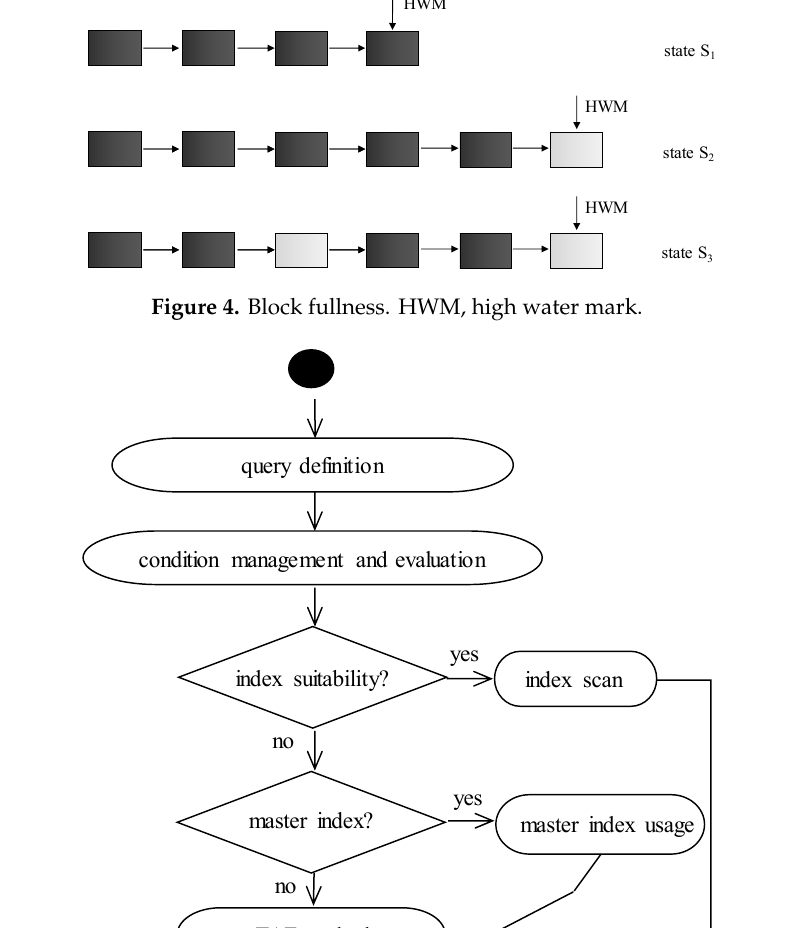
Figure 5. Data flow—Index access selection.